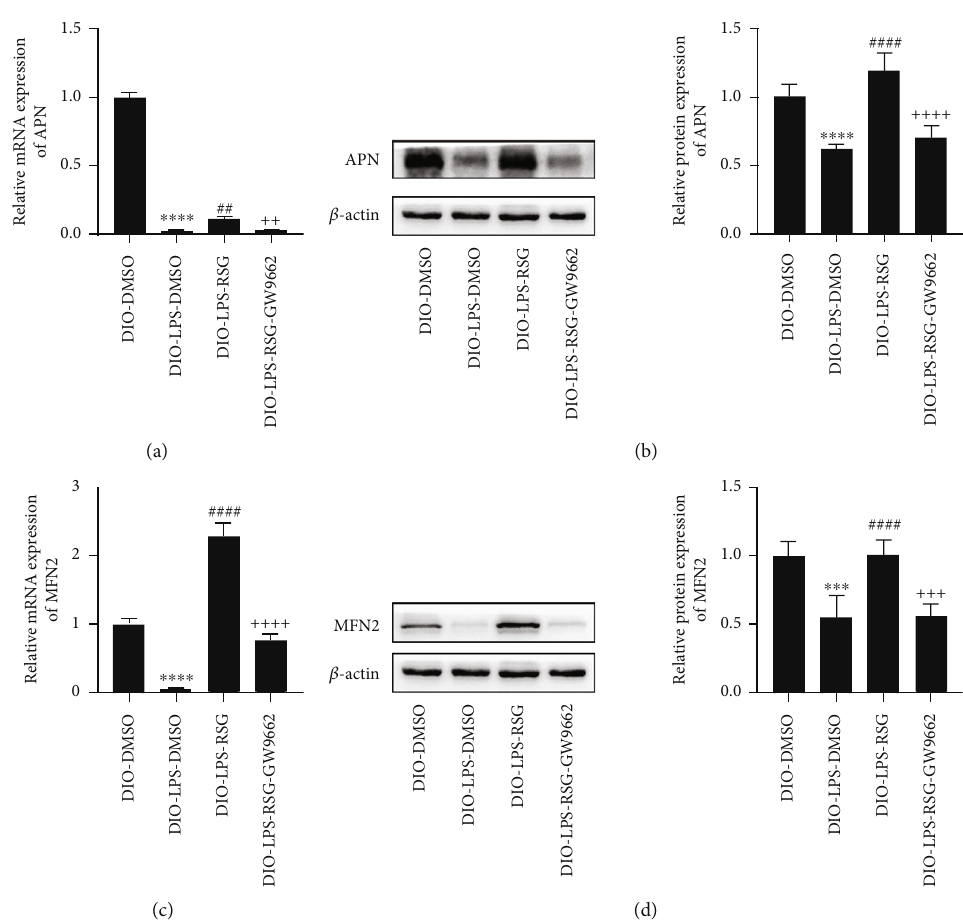
Figure 10: Activation of PPAR γ promoted APN and MFN2 expression in lung tissue of obese mice. (a) Relative mRNA expression of APN in lung tissue. (b) Western blotting and relative protein expression of APN in lung tissue. (c) Relative mRNA expression of MFN2 in lung tissue. (d) Western blotting and relative protein expression of MFN2 in lung tissue. Data are presented as mean ± SD . ∗∗∗ p < 0 : 001 , ∗∗∗∗ p < 0 : 0001 vs. DIO-DMSO; ## p < 0 : 01 , #### p < 0 : 0001 vs. DIO-LPS-DMSO; ++ p < 0 : 01 , +++ p < 0 : 001 , ++++ p < 0 : 0001 vs.